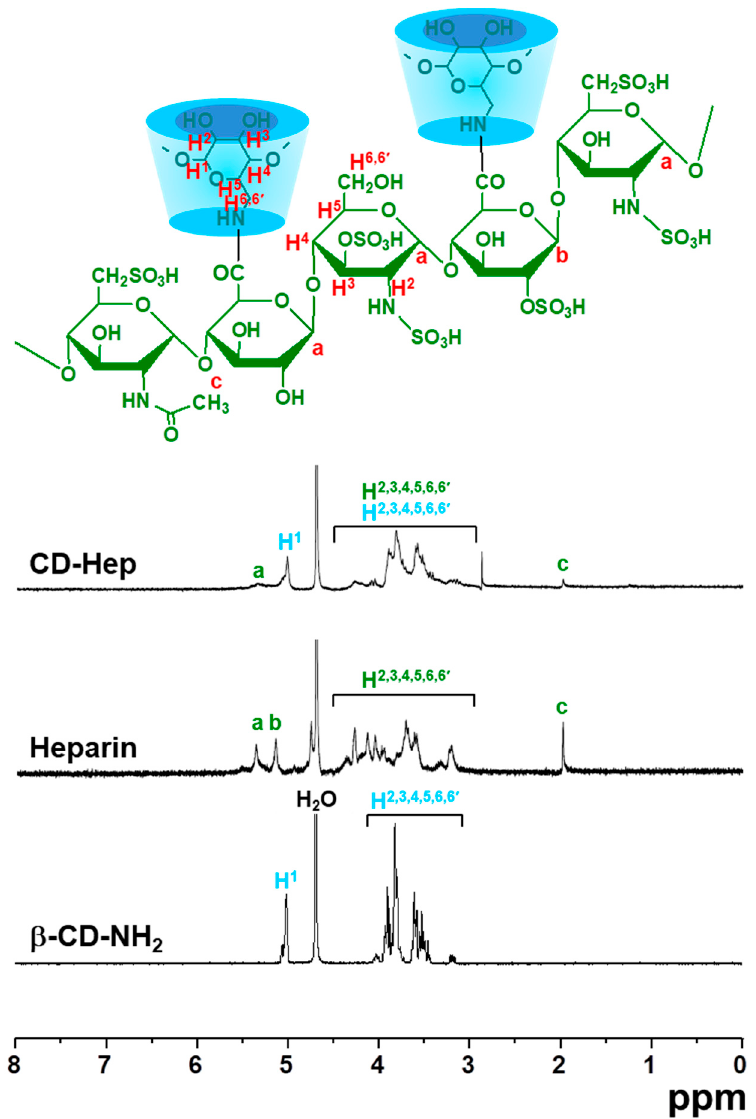
Figure 1. Proton nuclear magnetic resonance ( 1 H-NMR) spectra of β -cyclodextrin ( β -CD)-conjugated heparin (CD–Hep), measured in D 2 O. The signals of a, b and c indicates the acetyl group of N -acetyl- D -glucosamine in the molecular structure of heparin, the H 1 of 6-monodeoxy-6-monoamino- β -cyclodextrin ( β -CD–NH 2 ) and the H 1 of D -glucuronic acid, respectively.